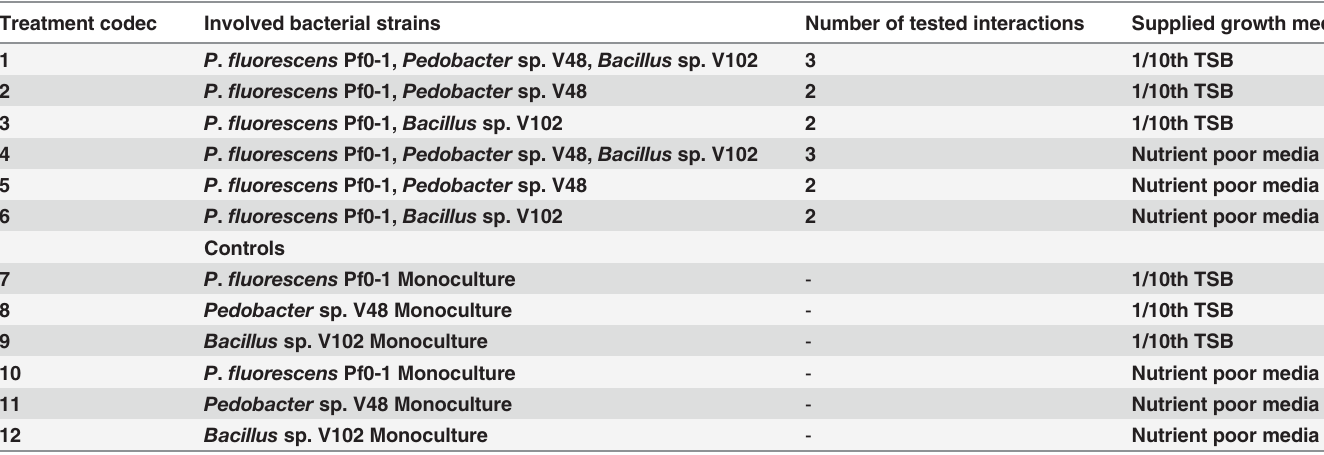
Table 2. Overview of the twelve microcosm treatments. Treatment